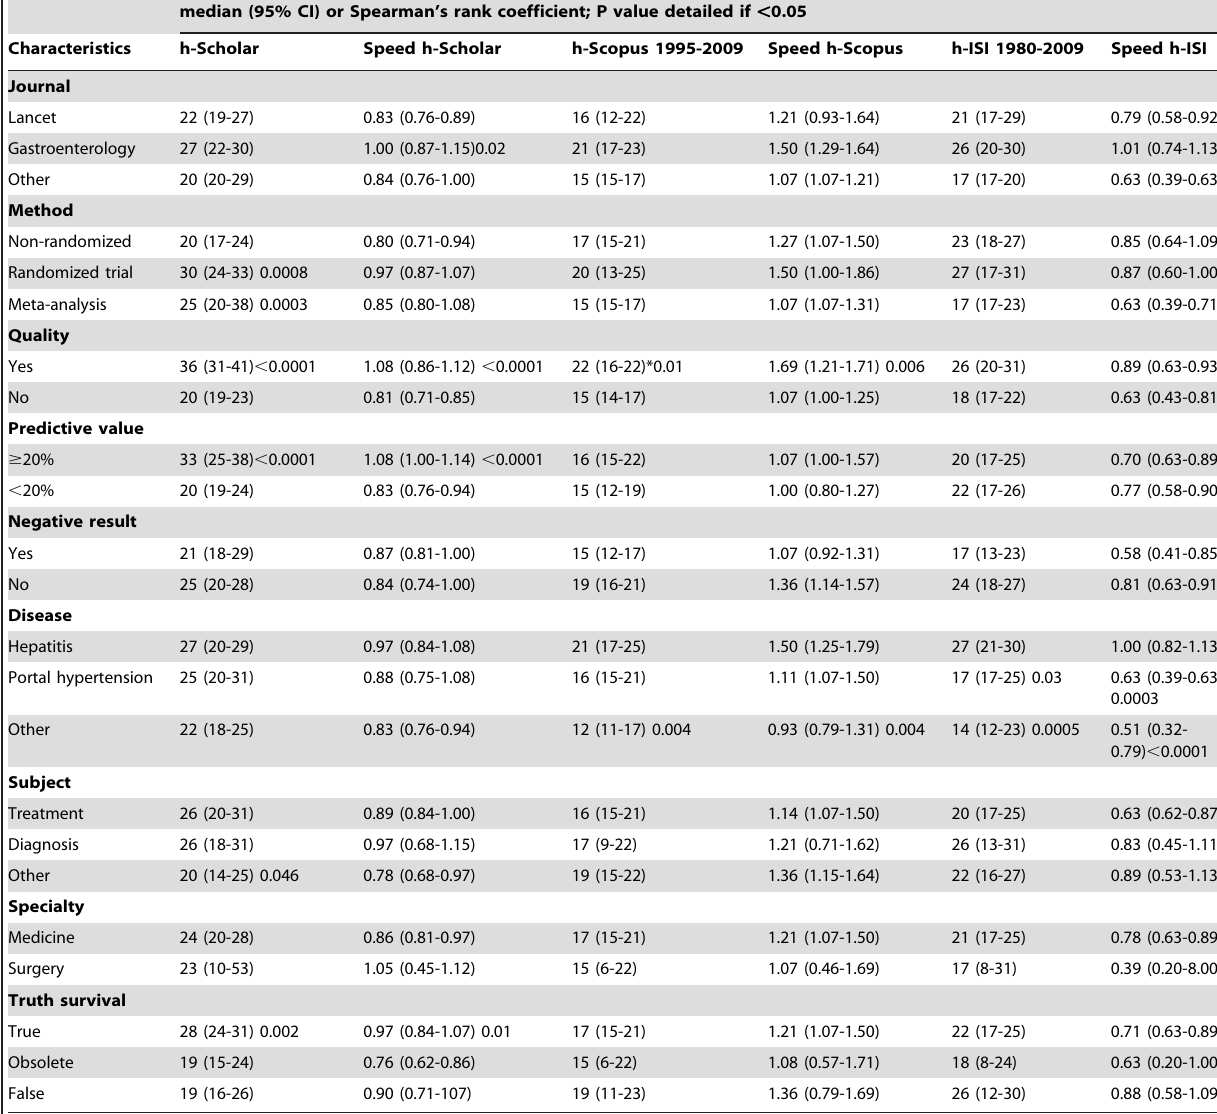
median (95% CI) or Spearman’s rank coefficient; P value detailed if ,